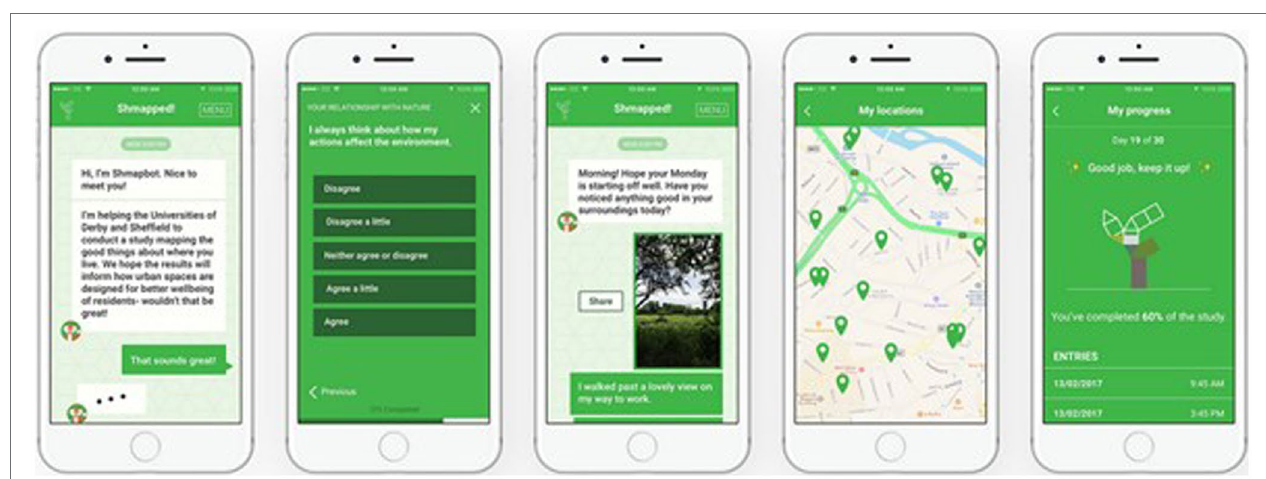
FIGURE 2 | Example of Shmapped app